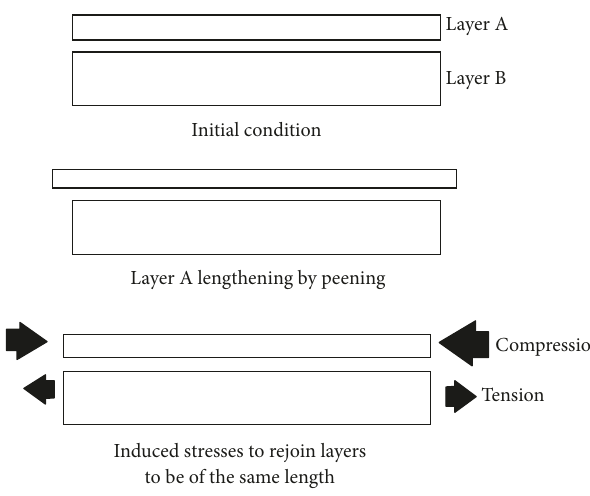
Figure 1: Creation of residual stress in a two-bar system